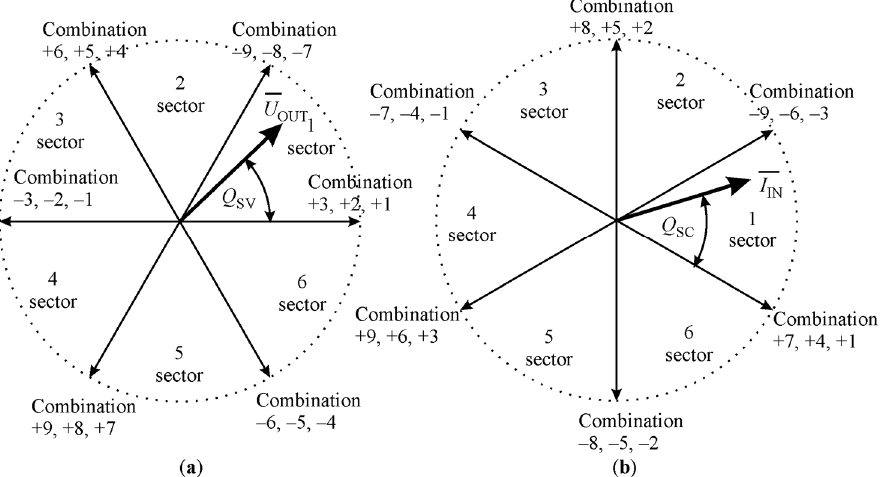
Figure 8. Graphic interpretation of bidirectional switch combinations: ( a )sectors and direction of the output voltage vectors; ( b )sectors and directions of the input line current vectors.